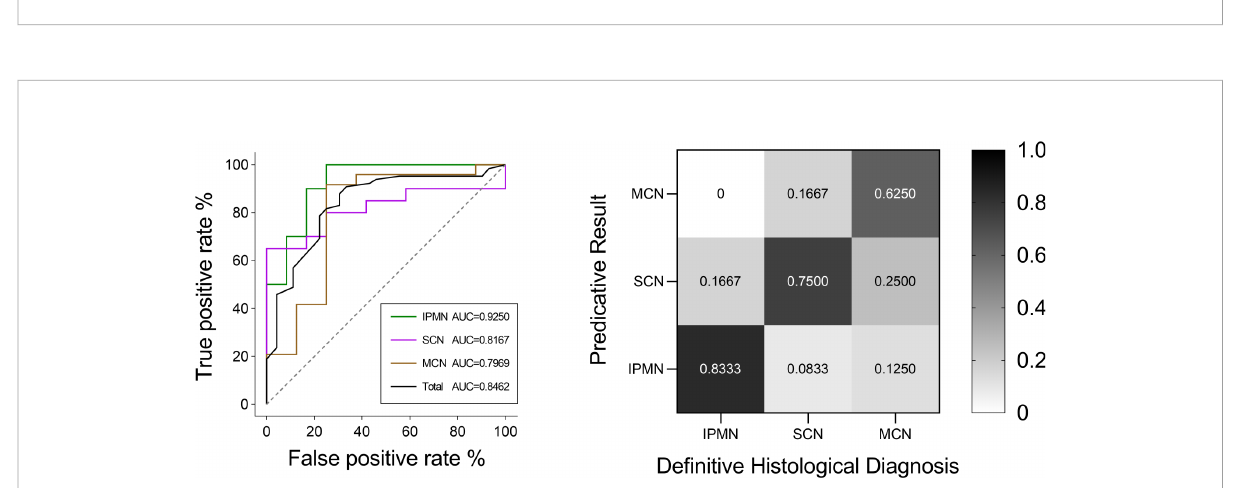
FIGURE 8 ROC curves of IPMN, SCN, and MCN and the total cases in the test group. The fi nal AUC values of IPMN, SCN, and MCN were 0.9250, 0.8167, and 0.7969, respectively. In addition, the mean AUC value of test group was 0.8462. ROC, receiver operating characteristic; AUC, area under the ROC curve. Relative confusion matrix of the three categories. Right color bar represents color coding of predicative rates from 0 to